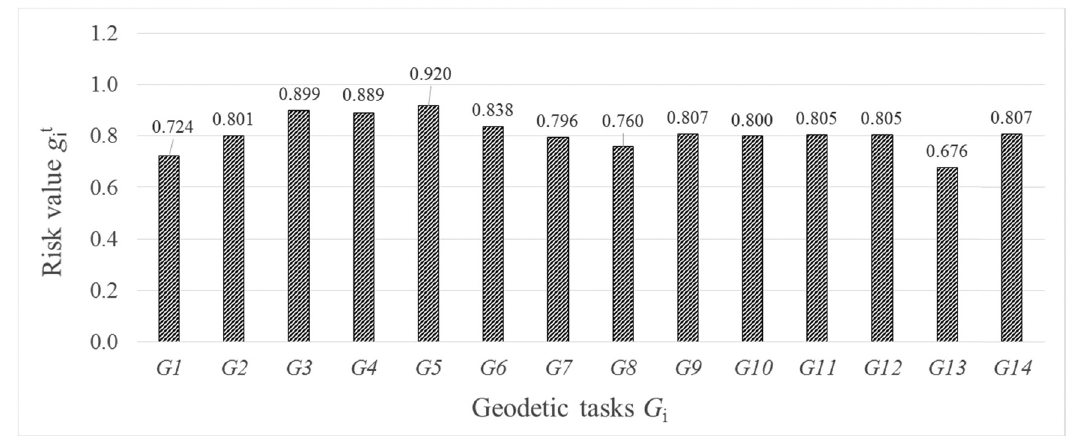
Figure 2: The risk value for the i - th geodetic task considering the extended duration of works.